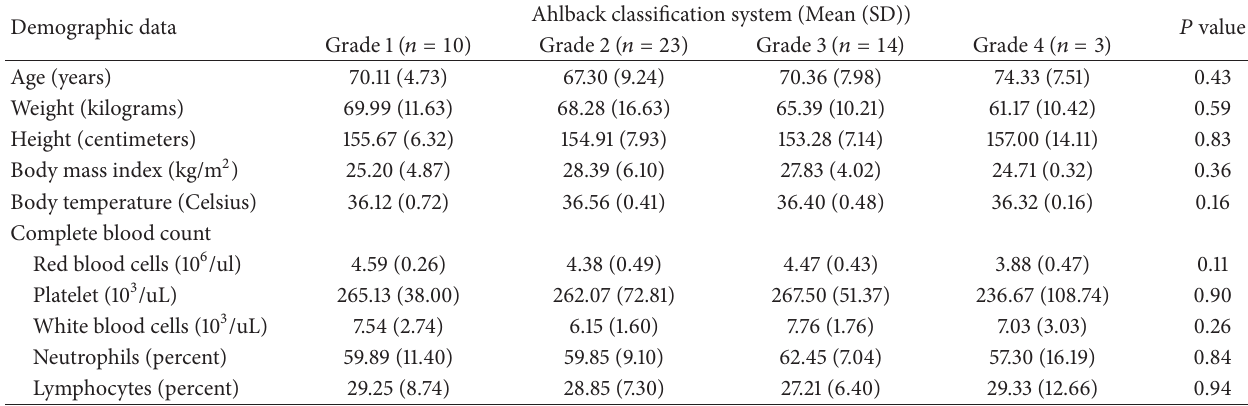
Table 1: Demographic characteristics of patient